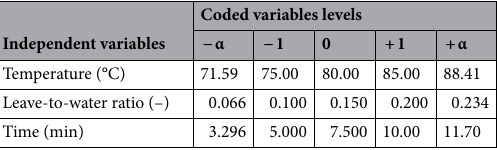
Table 1. Central composite design for multi-response optimization of spray-dried bancha green tea.